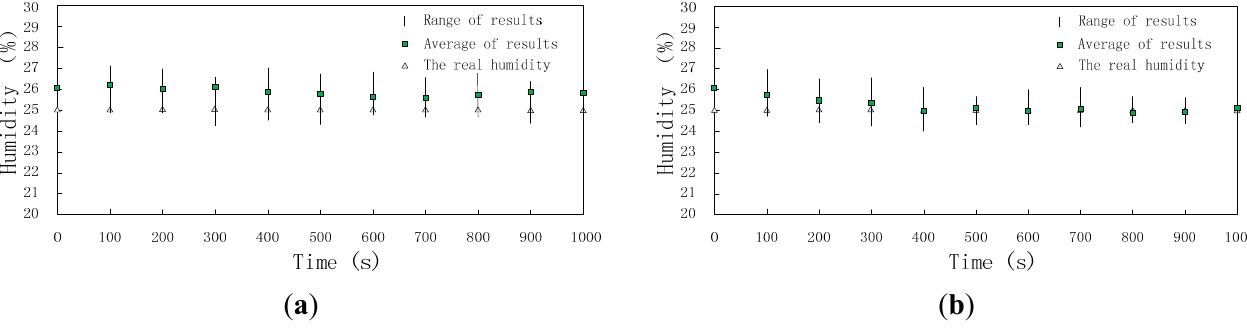
Figure 13. Data fusion results of humidity versus time; ( a ) without DCHM and ( b ) using